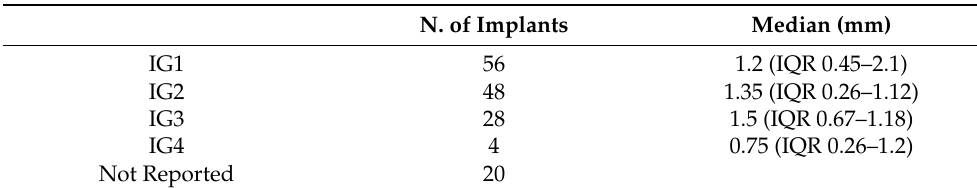
Figure 6. MBL distribution at different follow-up years. Different scores of oral hygiene were established in our department on an empirical Table 2. MBL comparisons between group A and B. basis (0 = bad, 1 = low, 2 = decent, 3 = good, 4 = optimal) (Table 3). Between the scores, no statistically significant difference in relation to MBL was observed. (Table 3) (Figure 7). Table 3. Hygiene index and MBL with inter quartile ranges (IQR).